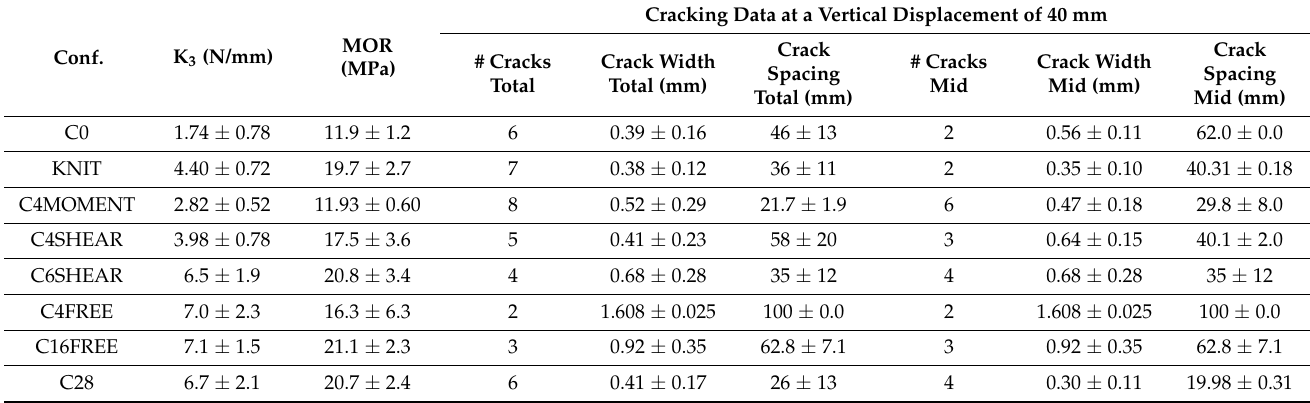
Figure 8. Comparison of the load-bearing behavior of the representative sample for each spacer configuration, demonstrating the positive influence of the spacer connections. The dashed line indicates the displacement level (40 mm) used for the DIC analysis. Table 3. Summary of experimental results for the considered configurations.